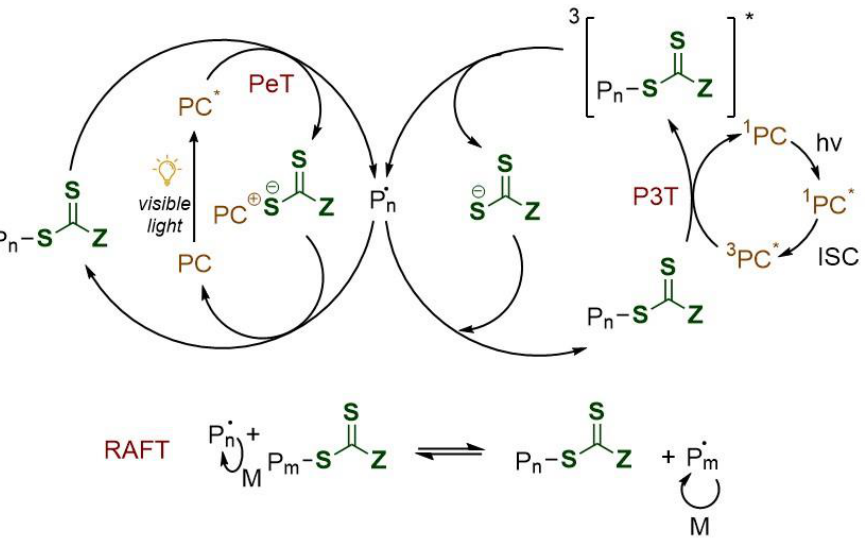
Figure 3. Proposed mechanisms for PeT ( left ) and P3T ( right ) RAFT polymerization. PC: photocatalyst; PeT: photoinduced electron transfer; P3T: photoinduced triplet energy transfer (Dexter electron exchange); ISC: intersystem crossing; *: excited state.